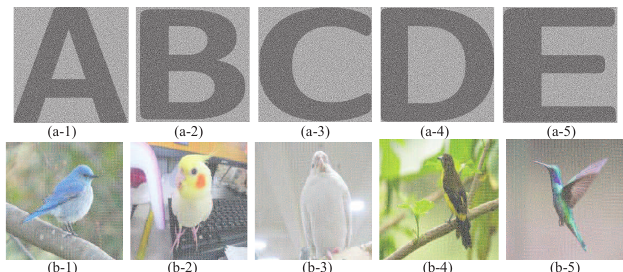
Figure 15. Binary snd color meaningful shadows of the proposed: ( a ) BS 1 − BS 5 ( b ) CS 1 − CS 5 .